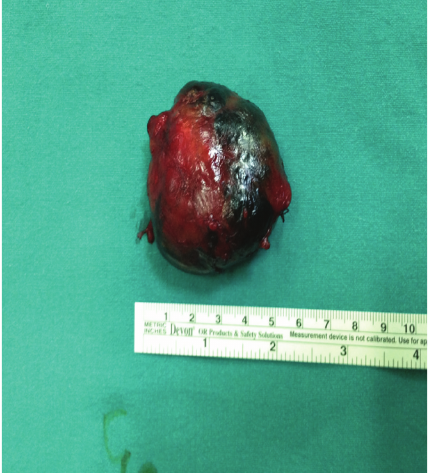
Figure 2: Postoperative appearance of the cystic mass after total